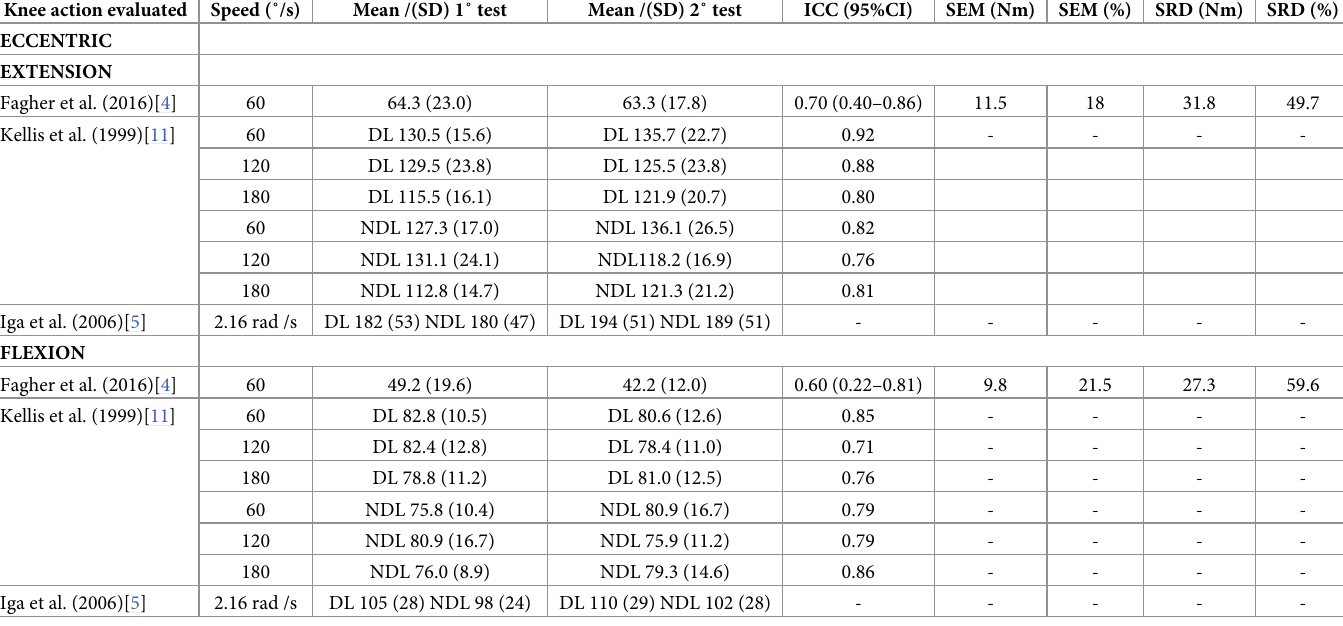
Table 5. Eccentric extension and flexion of the knee in isokinetic, intra-class correlation coefficient, standard error of measurement and smallest real difference of strength measurements. Knee action evaluated Speed